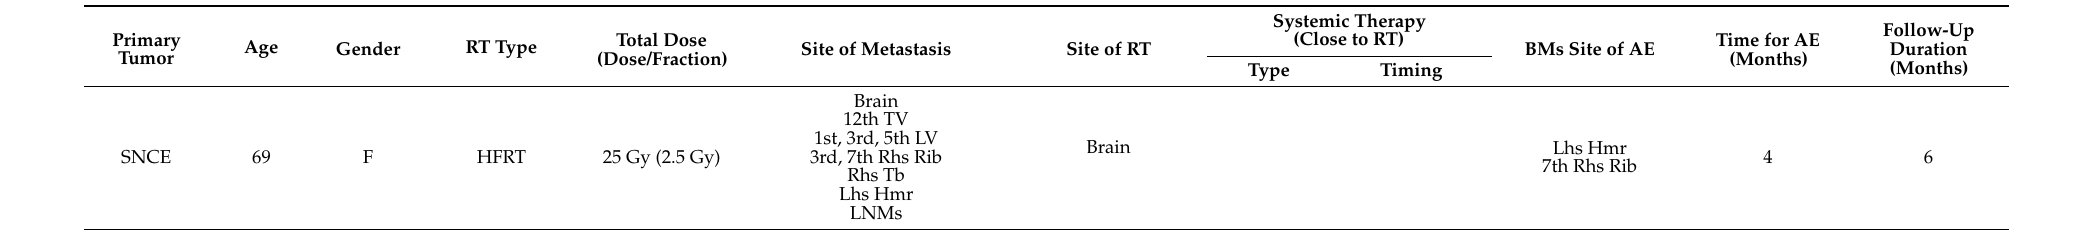
Table 2. Characteristic of the patients and treatments experiencing AE of BMs after RT in our